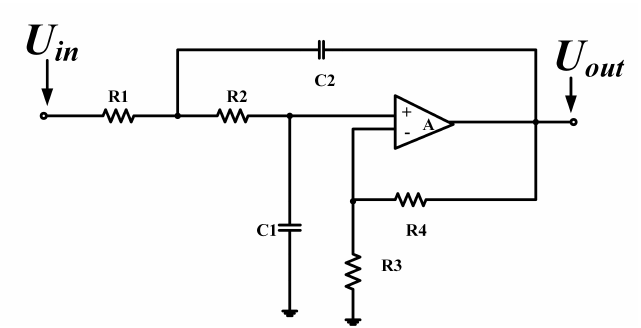
Figure 12. Two staged voltage-controlled low-pass